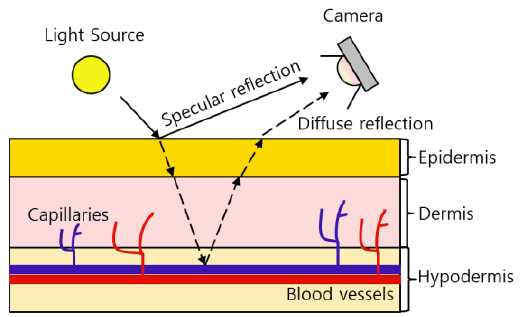
Figure 2. The absorbance of hemoglobin according to the wavelength of light. Table 3. The dermis and epidermal thickness of 39 facial areas.